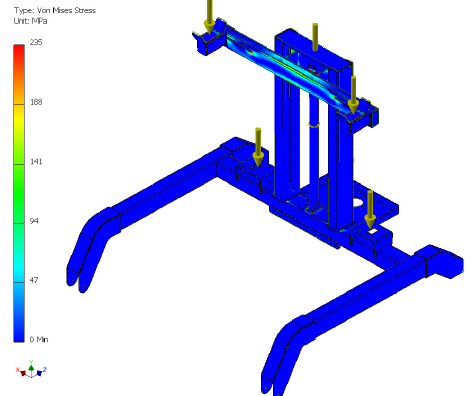
Figure 15. Equivalent von Mises stresses in the structure + lift arms set in the 1st FEM analysis